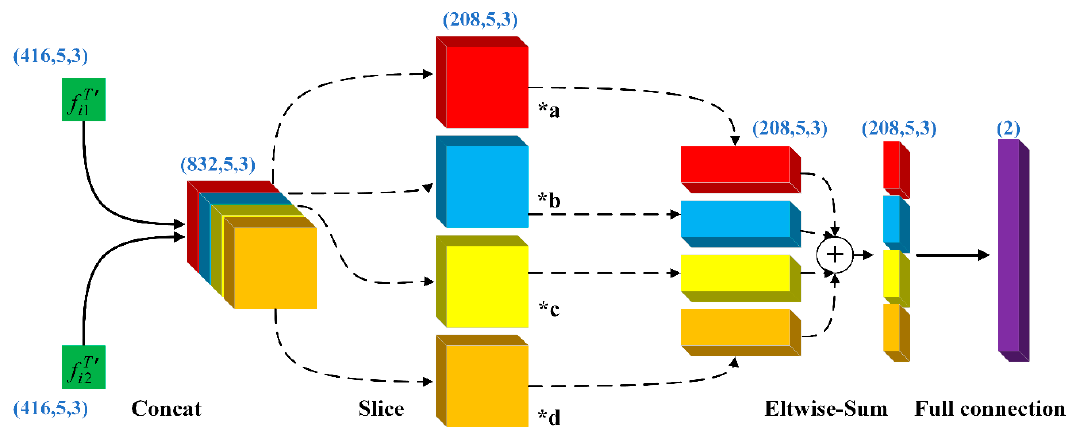
Figure 5. The process and detailed parameters of the salience-learning fusion layer. The blue font in the figure is the size of each layer input. The letters (“a” “b”, “c”, and “d”) are the weights